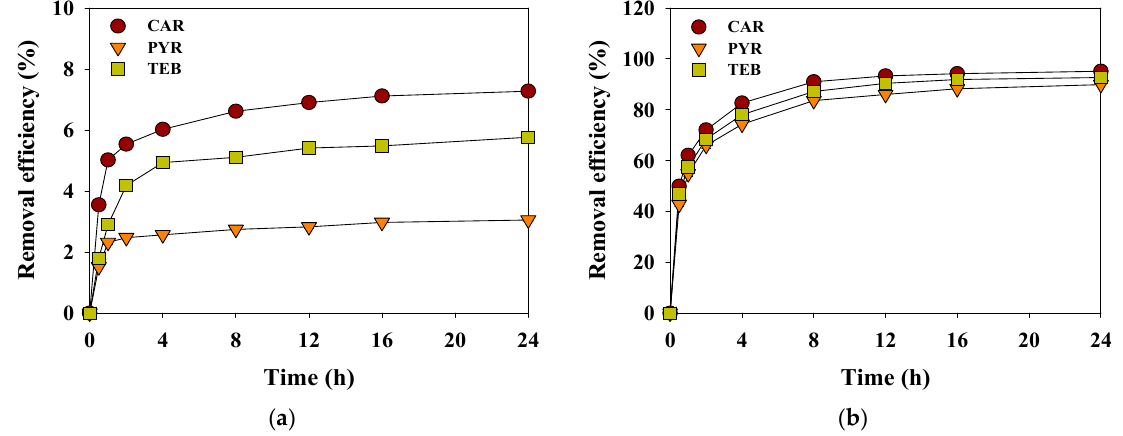
Figure 5. Adsorption kinetics of the selected fungicides using ( a ) PSB and ( b ) PSB OX-A (agitation speed = 150 rpm; absorbent dosage = 50 mg L − 1 ; initial concentration of each fungicide = 10 μ M; temperature = 25 °C; pH = 7.0).